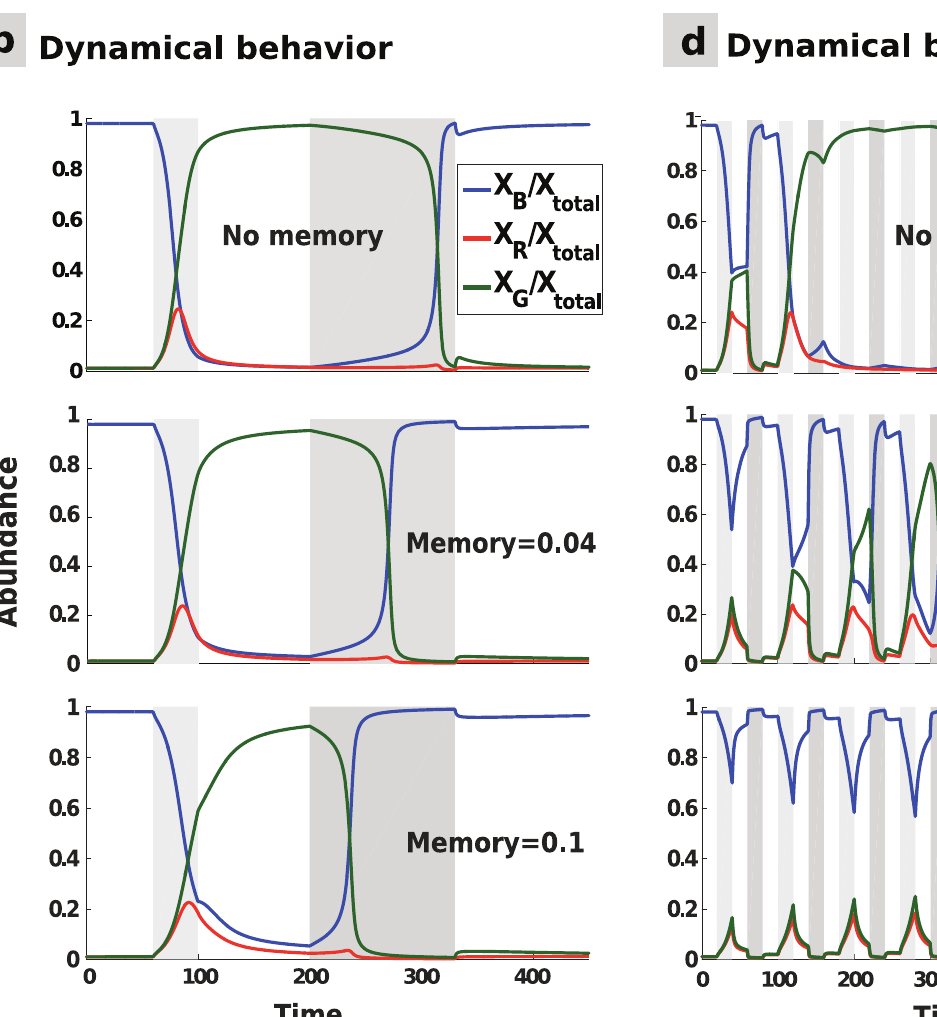
Fig 3. Multi-pulse and periodic perturbations: Commensurate memory impact on hysteresis and transient oscillations. (A) Two opposite pulse perturbations are applied successively: the blue species growth rate is first briefly lowered, and then raised for a longer time. (B) The top panel shows the hysteresis in the system: the state shift towards the dominance of the green species occurs faster after the first perturbation than the shift back to the initial stable state after the second perturbation. Introducing commensurate memory (middle and bottom panels) delays the first state shift, thus increasing resistance, and hastens the second state shift, thus mitigating the hysteresis effect and increasing long-term resilience. (C) Rapidly alternating opposite